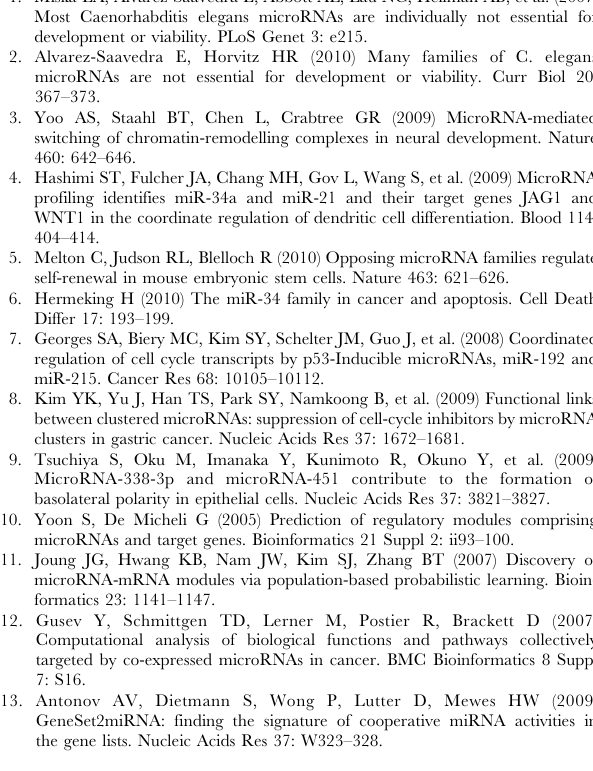
Table S1 253 human-mouse mature orthologous miRNAs. Table S2 Significance of overlapping affected genes between conserved co-expressed miRNA pairs using miRNA knockout/ transfection expression